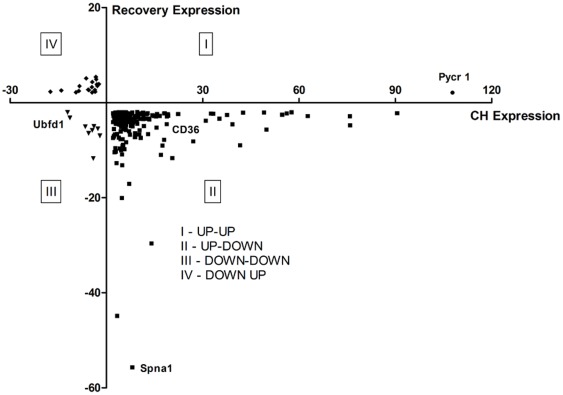
Fold change relationship of differential gene expression.The 230 differentially expressed genes were divided into four different sets according to their expression over time. The abscissa represents the fold change of the CH transcript expression profile, and the ordinate represents the fold change of the REC transcript expression profile. The first quadrant (I) shows one gene (circle) up-regulated in both CH and REC. The second quadrant (II) shows the 202 genes (square) up-regulated during CH and down-regulated after REC. The third quadrant (III) shows the 9 genes (triangle) down-regulated in both CH and REC conditions. The fourth quadrant (IV) shows 18 genes (diamond) which are down-regulated during CH and up-regulated after REC.